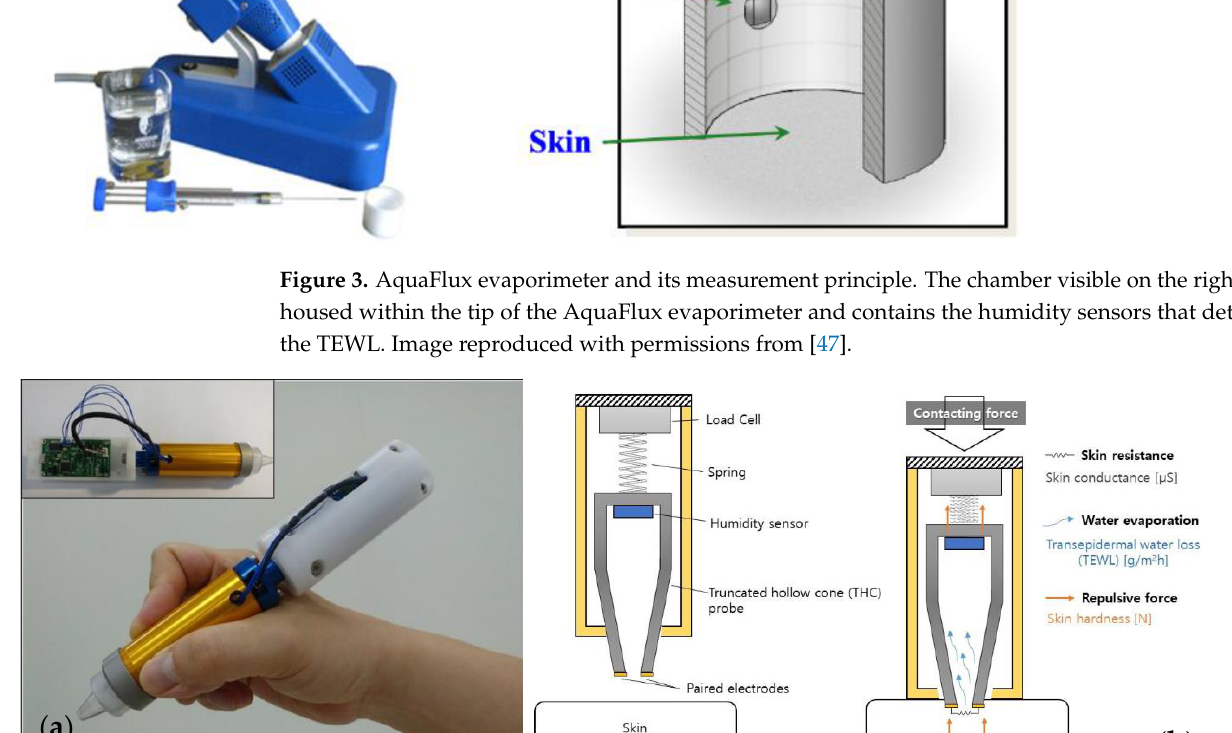
Figure 3. AquaFlux evaporimeter and its measurement principle. The chamber visible on the right is housed within the tip of the AquaFlux evaporimeter and contains the humidity sensors that detect the TEWL. Image reproduced with permissions from [47].